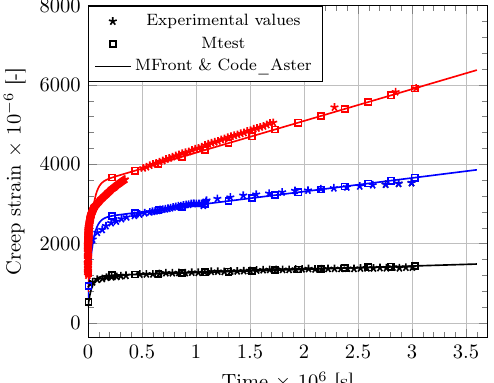
Figure 2. Comparison between theoretical and experimental strain for the bulk epoxy adhesive submitted to tensile creep at 5 MPa (black), 8 MPa (blue) and 10 MPa (red).